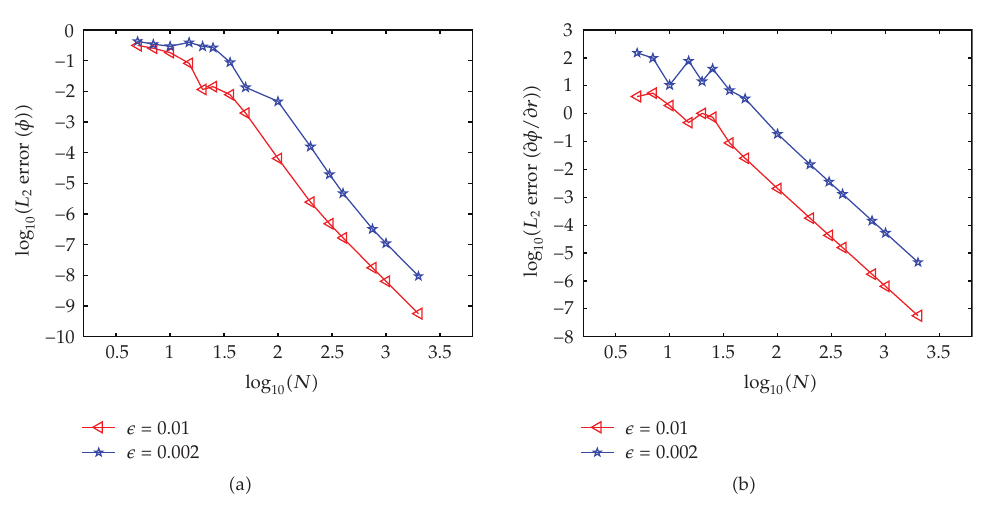
Figure 2: Comparisons of convergence rates of the fourth-order compact schemes for problem 1 at di ff erent